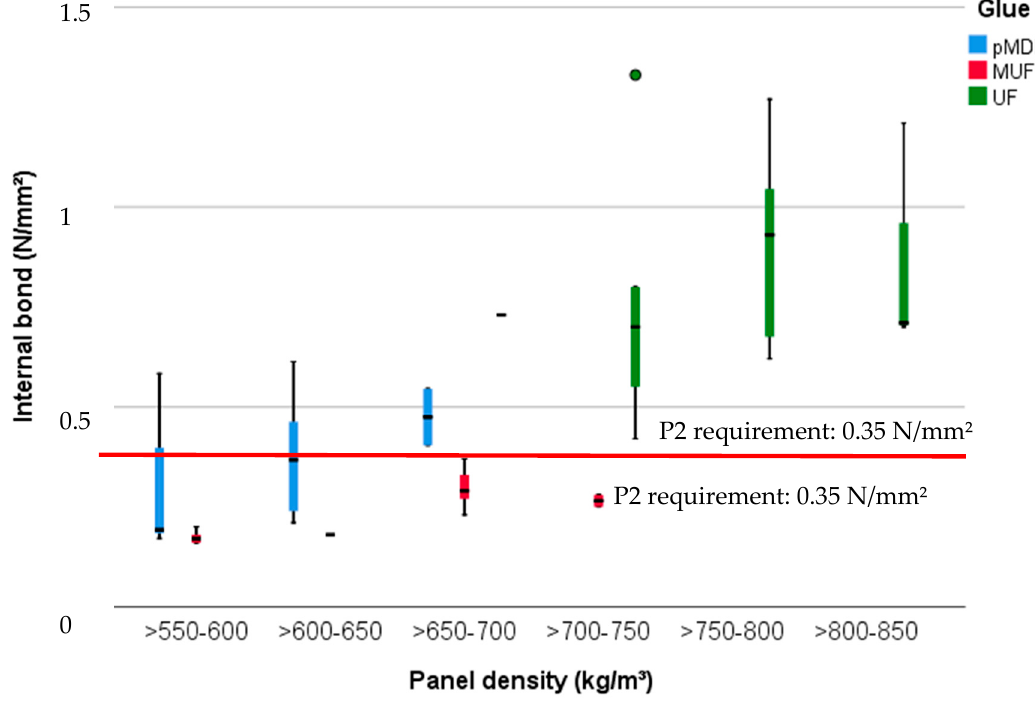
Figure 4. Internal bond of the 15 mm PB samples with densities between 500 and 850 kg/m³ and glued with pMDI, UF and MUF.